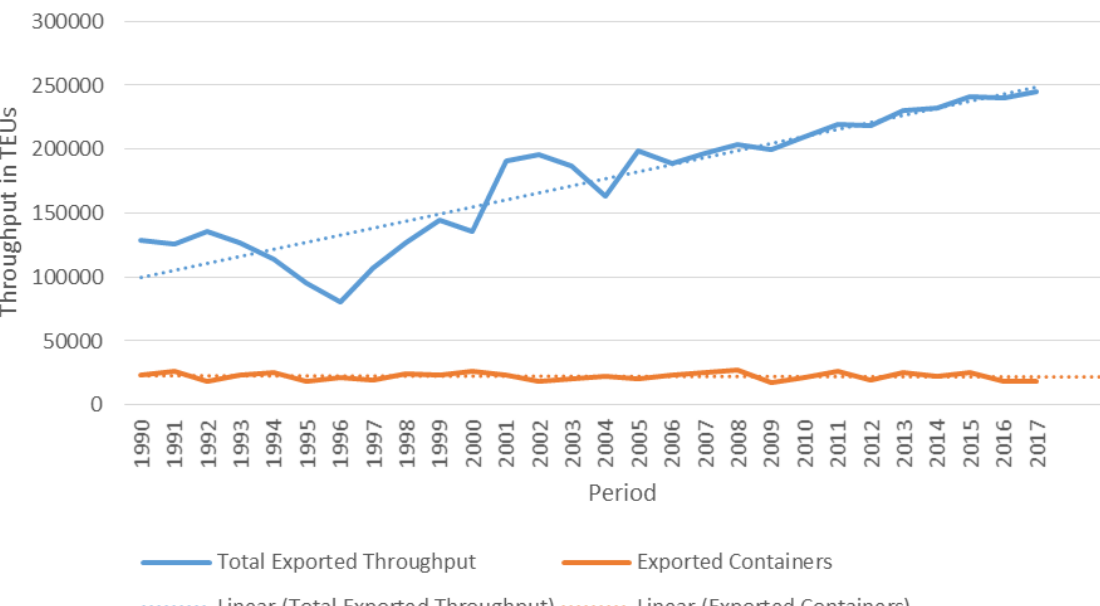
Figure 5: Relationship between the year and total exported container